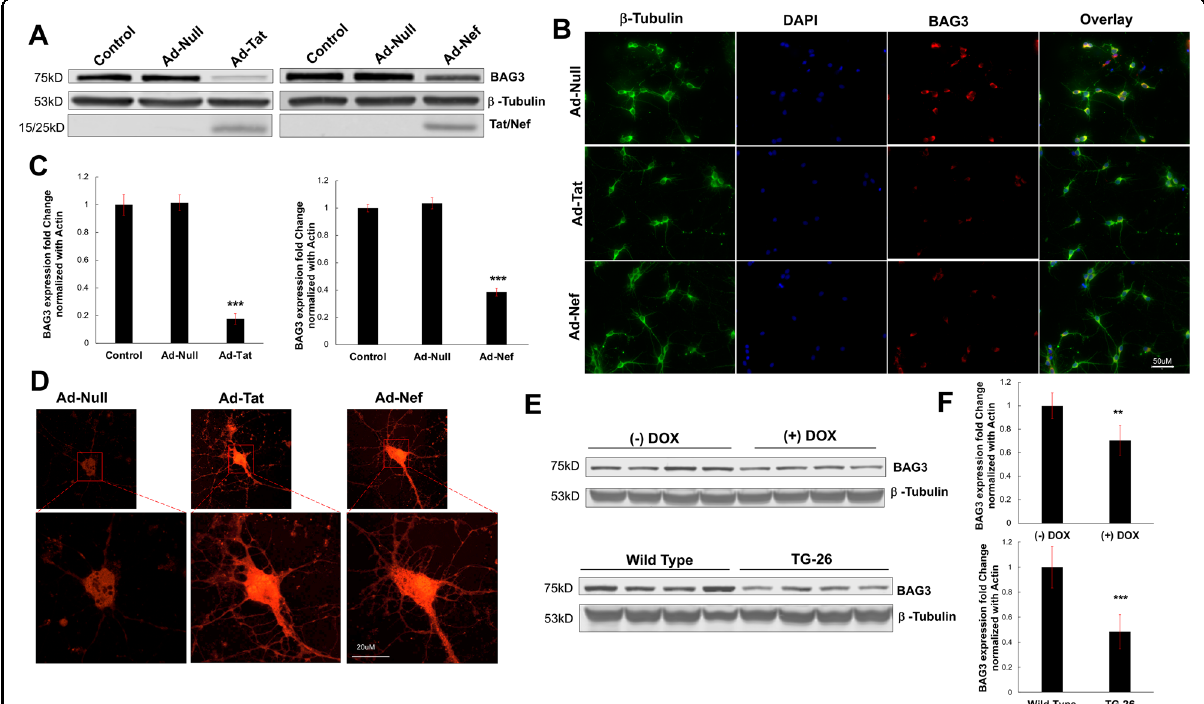
Fig. 1 HIV-1 proteins (Tat and Nef) decrease BAG3 and increase ROS. A Western blot results illustrated the neuronal expression of either HIV-1 viral protein, Tat, or Nef, resulted in decreased protein levels of BAG3. B Immunocytochemistry analysis validated the reduction in BAG3 protein when compared to control conditions. C qPCR results further con fi rmed the effect of HIV-1 viral proteins on BAG3, demonstrating a signi fi cant decrease in its RNA following Tat or Nef expression. D Live-cell microscopy indicated signi fi cantly increased ROS in neurons exposed to either Tat or Nef. E Results from the frontal cortex of two HIV animal models indicated minor decreases in BAG3 protein were maintained in vivo, particularly in Tg26 mice. F qPCR results indicated signi fi cant in vivo reductions in BAG3 RNA across both HIV animal models. ** p < 0.01; *** p < 0.001. Scale bar equals 50 μ M; ×20 magni fi cation. Scale bar equals 20 μ M; ×60 magni fi